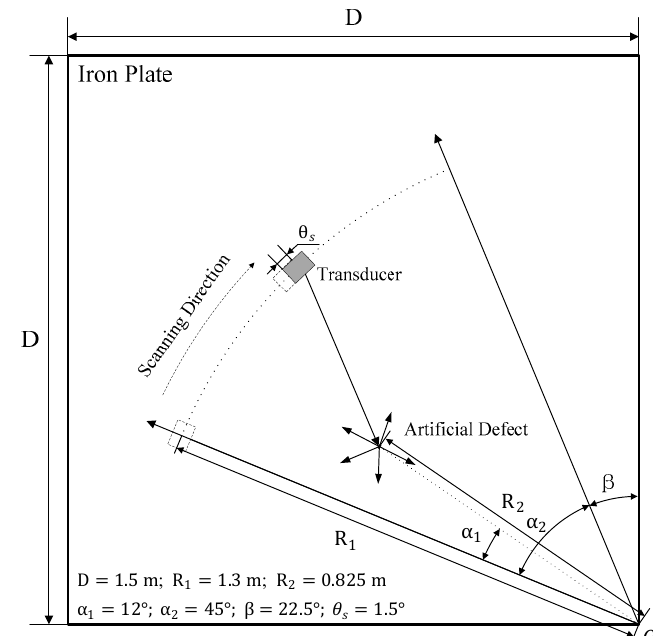
plate. the plate. Appl. Sci. 2018 , 8 , x